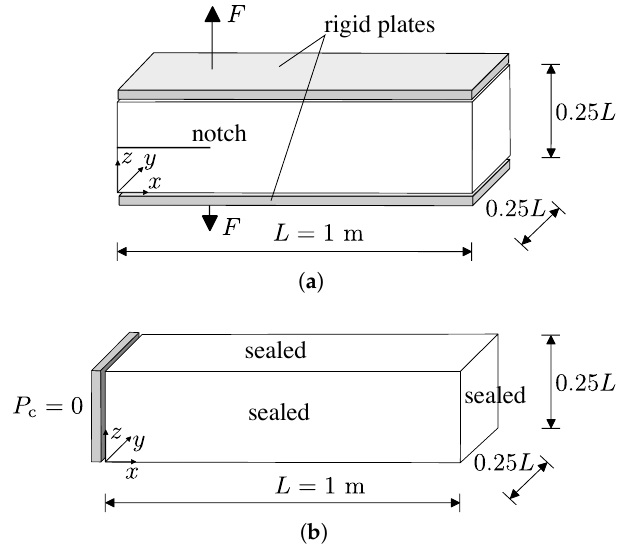
Figure 9. Geometry and loading setup of the structural ( a ) and transport ( b )